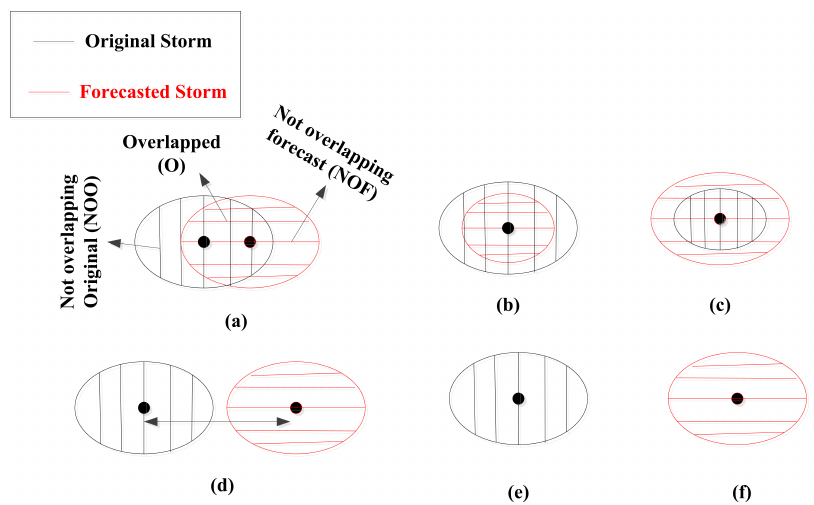
Figure 15. The black ellipse depicts the current (original) storm, while the red ellipse the forecasted one. ( a ) Both storms overlap each other; ( b ) underestimation; ( c ) overestimation; ( d ) missing location; ( e ) missing event; ( f ) false